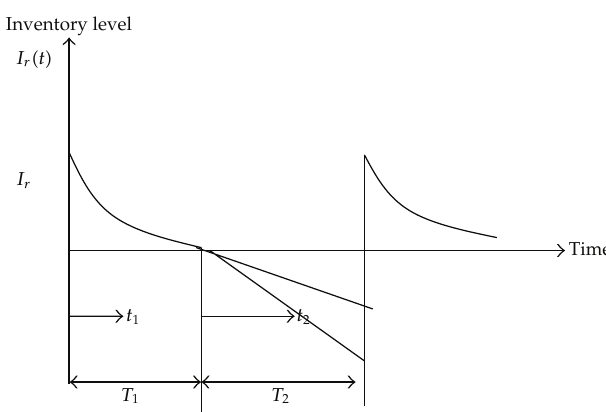
Figure 3: Graphical representation of the RW inventory system (cid:2) one warehouse-rented (cid:3)